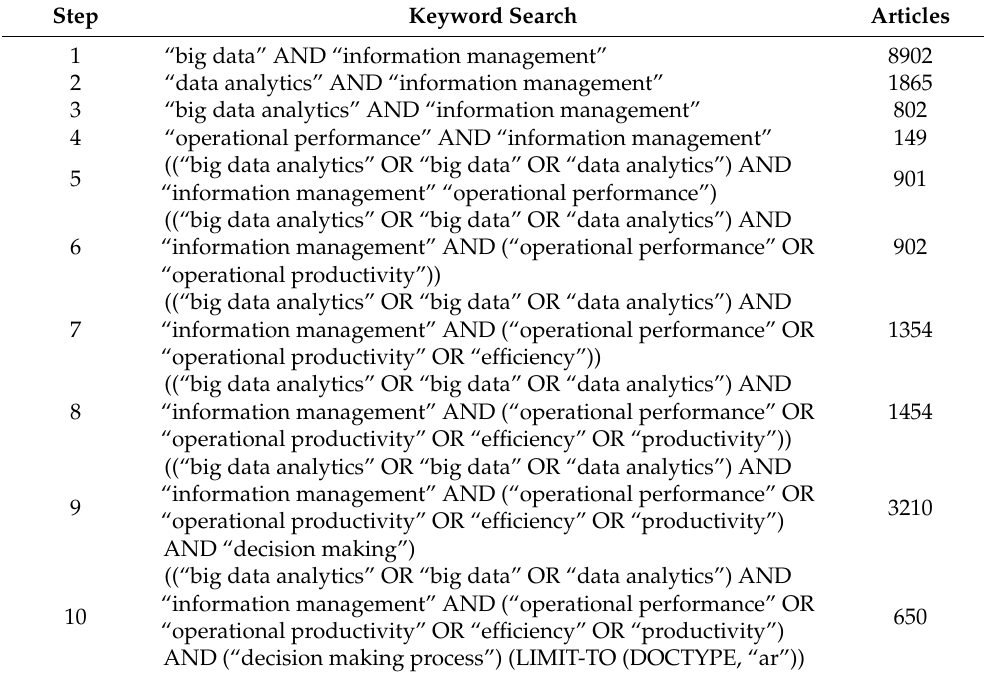
Table 1. Keyword search process in Scopus